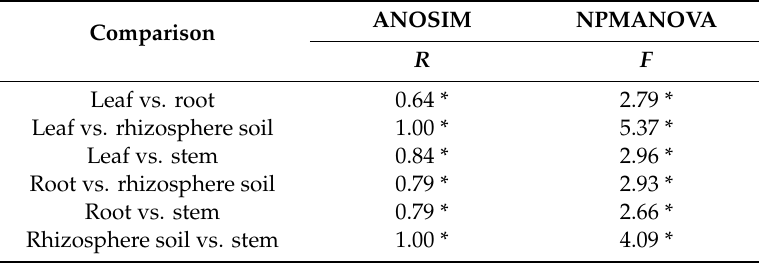
Table 2. Results of analysis of similarities (ANOSIM) and nonparametric multivariate analysis of variance (NPMANOVA) based on Jaccard distances and presence / absence data in comparisons of fungal community composition in indicated pairs of soil and plant